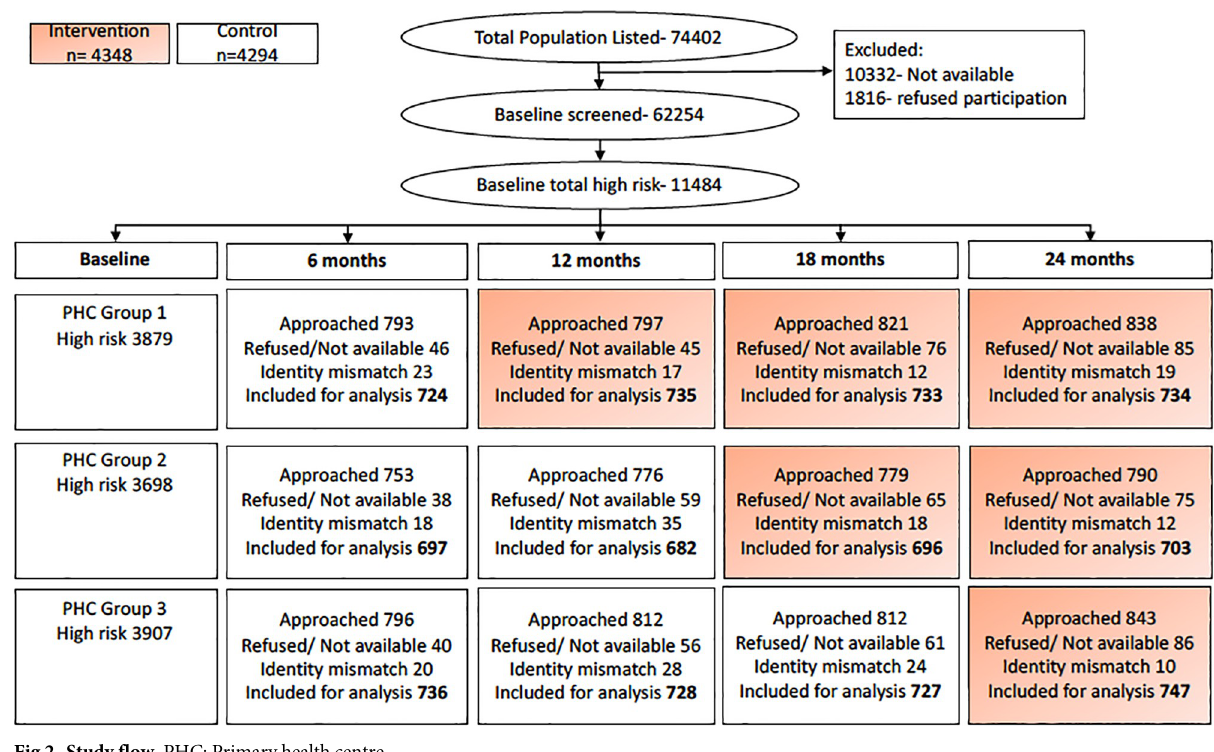
Fig 2. Study flow. PHC: Primary health